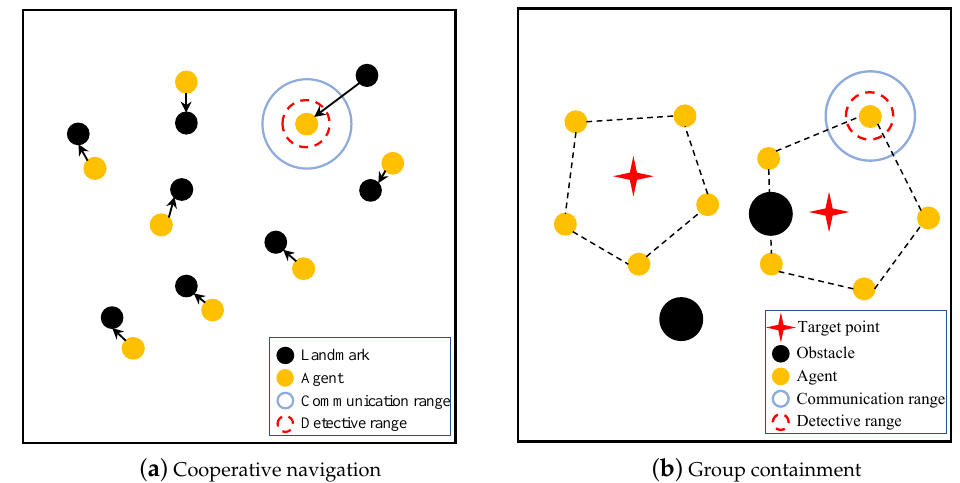
Figure 6. The illustration of simulation